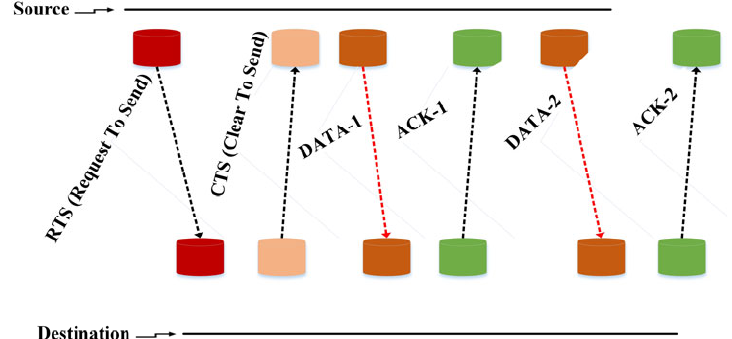
Figure 4. Result of RTS/CTS with CSMA [43].